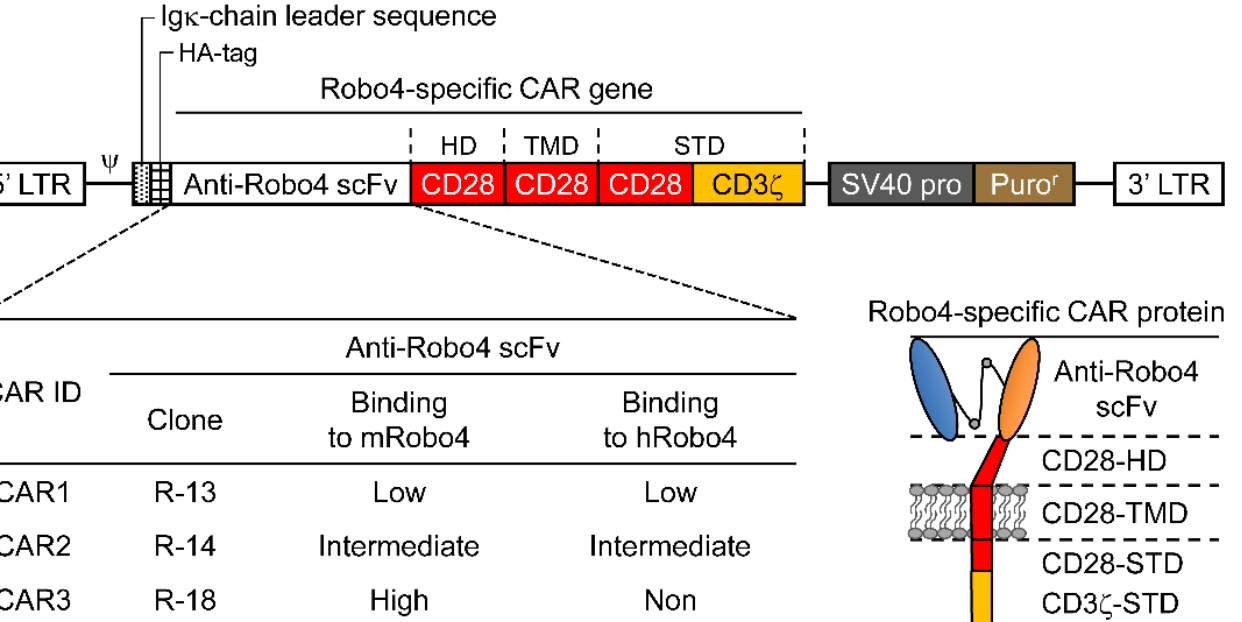
Figure 1. Illustration of roundabout homolog 4 (Robo4)-specific chimeric antigen receptors (CARs) with antigen-recognition domain (ARD) modification. Top, diagram of Robo4-specific second-generation CAR retroviral DNA constructs; lower left, binding of the three CAR inserts to mouse and human Robo4; lower right, diagram of Robo4-specific CAR protein. HA, hemagglutinin; HD, hinge domain; scFv, single-chain variable fragment; STD, signal transduction domain; TMD, transmembrane domain.